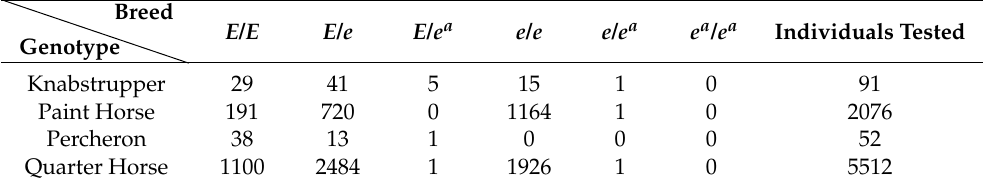
Table 1. Observed genotype counts for the MC1R locus in the four breeds in which the chestnut e a allele ( MC1R :p.D84N) was